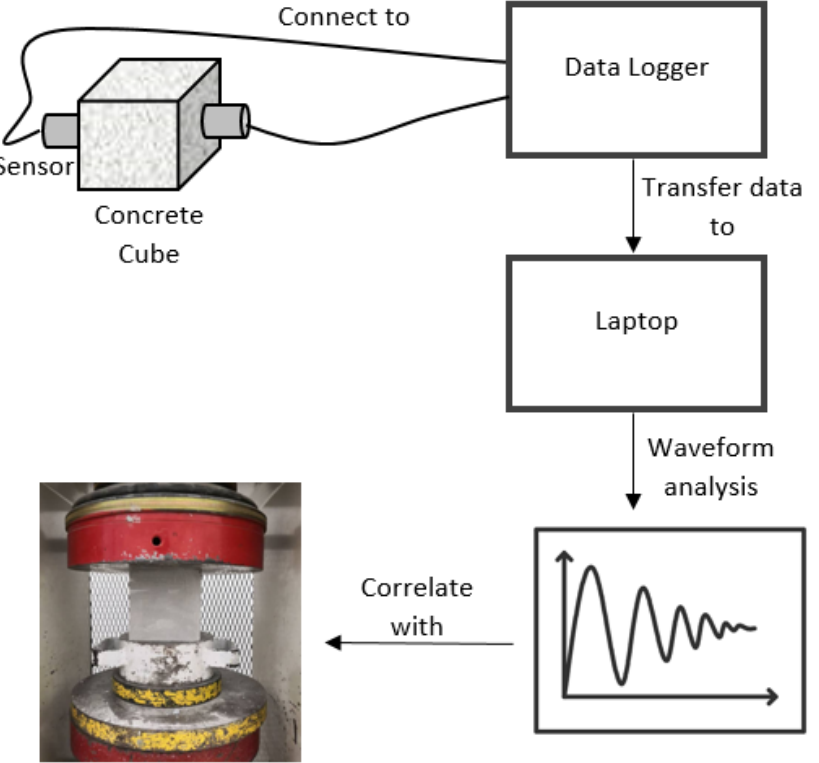
Figure 2. Sketch of the experimental set up